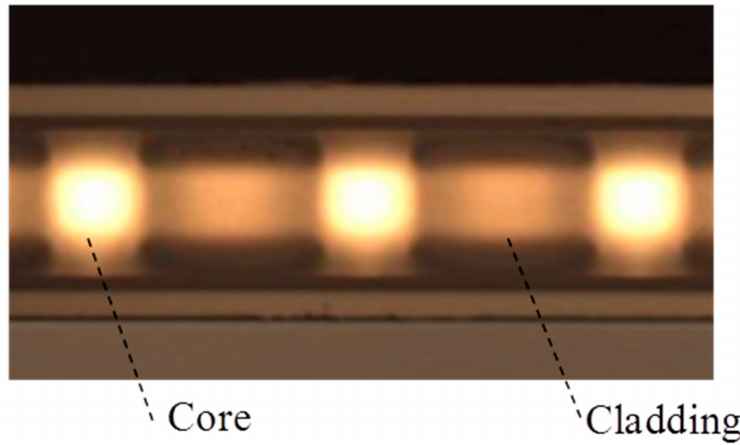
Figure 4. Cross section of addressed GI